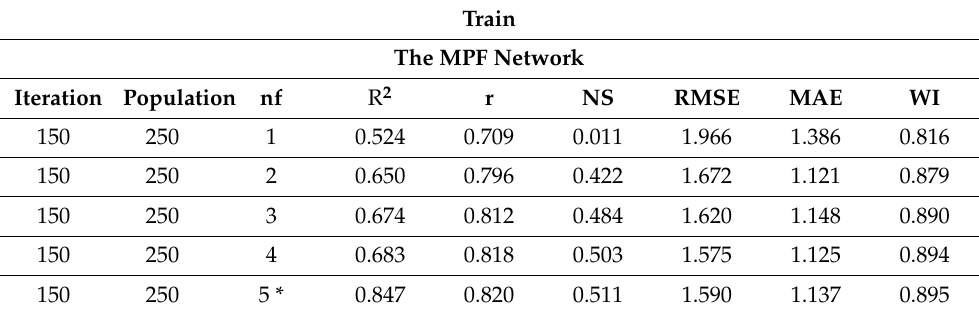
Figure 29. The MPF (five inputs) error histograms for ultimate load prediction: ( above ) training phase and ( bellow ) testing phase. Table 12. Calculated accuracy criteria of the MPF model for the performance of the implemented models to ultimate load prediction (iteration =